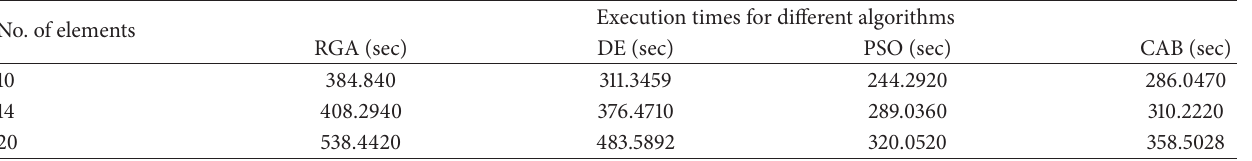
Table 5: Comparison of execution times for different algorithms for different sets of elements.